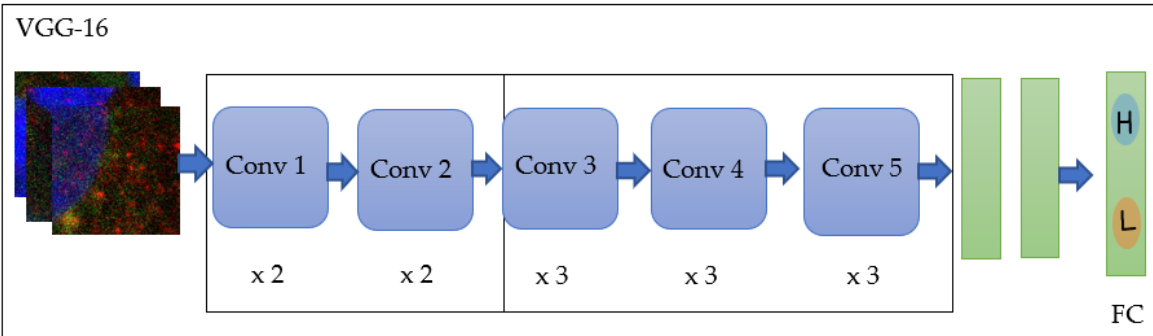
Figure 11. Architecture of the pre-trained models [37]. 4.4. Model 5-Fold Cross-Validation The CNN models were evaluated using a test set containing images of both high and low anticancer drug uptake, which had not been observed during the training stage. Each model was previously trained for ten epochs, and a batch size of sixty-four was decided empirically. The training was conducted using Adam as the optimiser as it worked effec- tively on our three- channel confocal images. Each model’s performance cross -validation was evaluated based on different metrics such as precision, sensitivity specificity, F-1 scores, and confusion metrics (Table 3). ROC curve and area under the curve (AUC) were presented from the last fold of each cross-validation (Figure 3). The parameters of the con- fusion metrics were used to determine each metric- True Positive (TP), True Negative (TN), False Positive (FP), and False Negative (FN) [38].